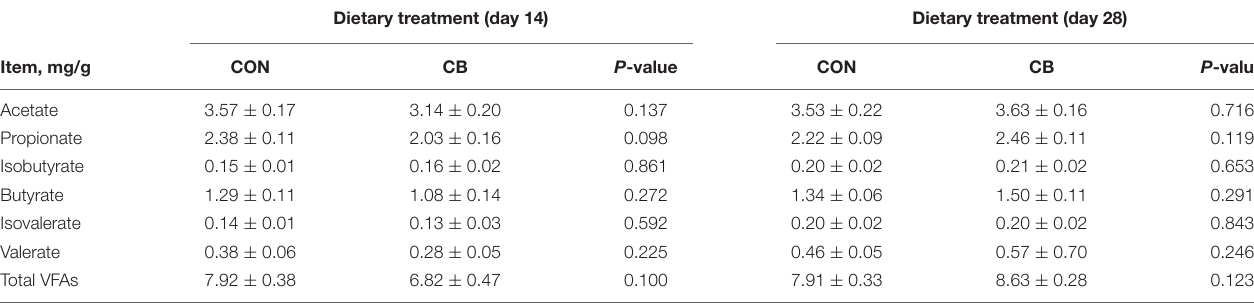
TABLE 4 | The effect of dietary corn bran on fermentation products in weaned pigs. Dietary treatment (day 14) Dietary treatment (day